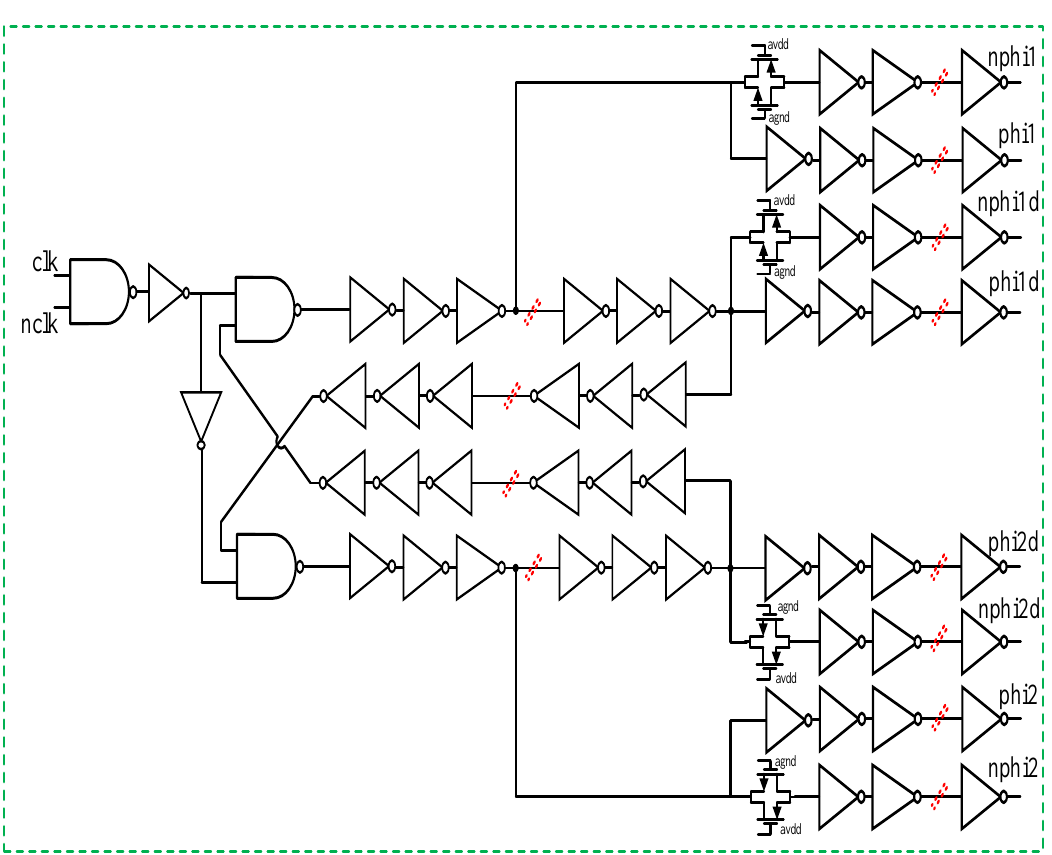
Figure 6. Non-overlapping clock generator.